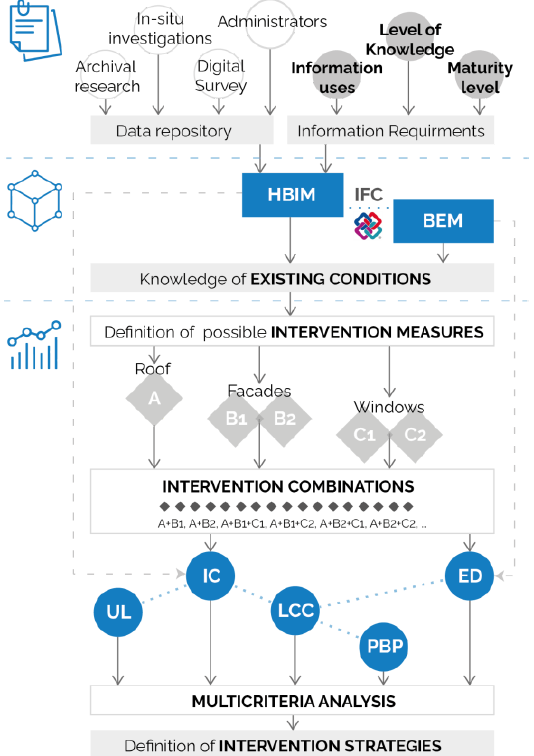
Figure 3. The data flow for determining the five parameters investigated in the multicriteria analysis.